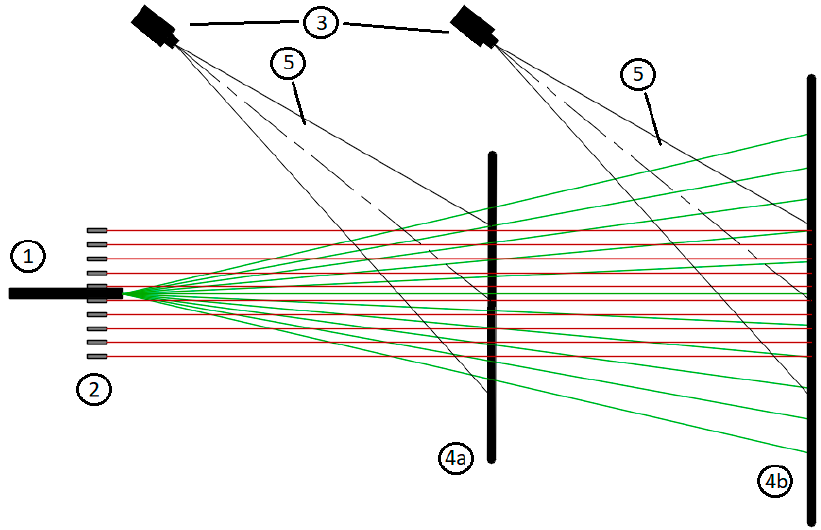
Figure 18. Diagram showing (1) a laser projection device, (2) an additional laser device, and (3) a set of cameras: (4a)—projection plane close to the projection device; (4b)—projection plane at a distance from the projection device, (5)—camera field of view.